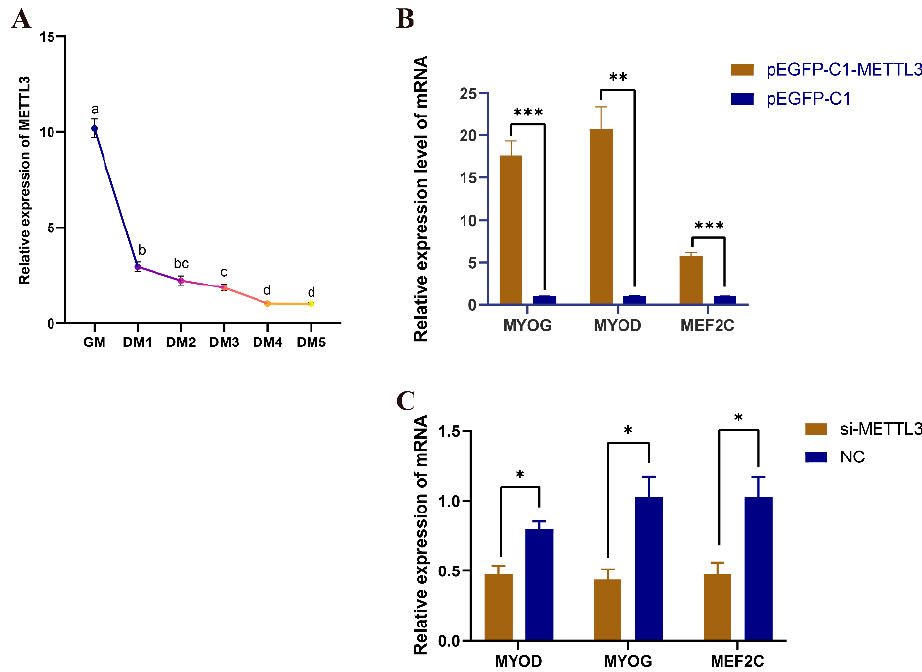
Figure 4. METTL3 promotes the differentiation of QM7 cells. ( A ) The expression level of METTL3 before and after QM7 cell differentiation. Different colors indicate the different differentiation stages of QM7. The signi fi cant di ff erences between the two groups are indicated by the distinct le tt ers ( p < 0.05). ( B ) The expression levels of MYOG , MYOD , and MEF2C after the overexpression of METTL3 . ( C ) The expression levels of MYOG , MYOD , and MEF2C after the knockdown of METTL3 . GM rep- resents growth medium and the cells undergo proliferation, whereas the di ff erentiation medium (DM) phases, DM1–DM5, represent the fi rst to fi fth day of di ff erentiation. * indicates p < 0.05; ** indicates p < 0.01; *** indicates p < 0.001.